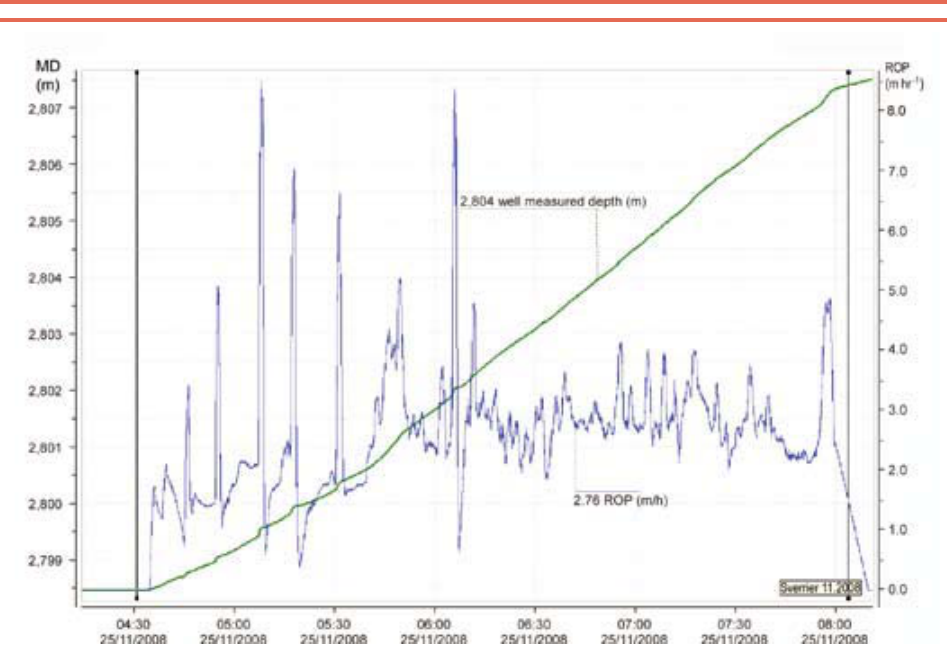
Figure 6. Time-coring rate (m h -1 ) diagram – 27 November 2008, 4:34–8:00, at 2800 m depth. Core recovery was close to 100% of 4" core. Average coring rate 2.6 m h -1 . The green curve shows increasing depth.